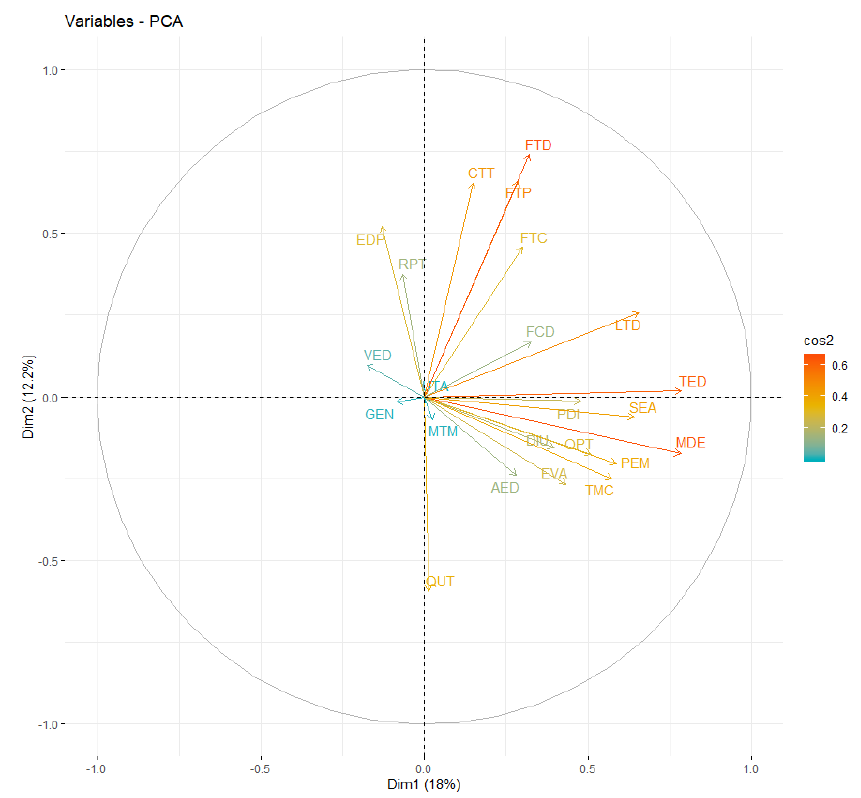
Figure 3. Principal component analysis (PCA) for the research variables.